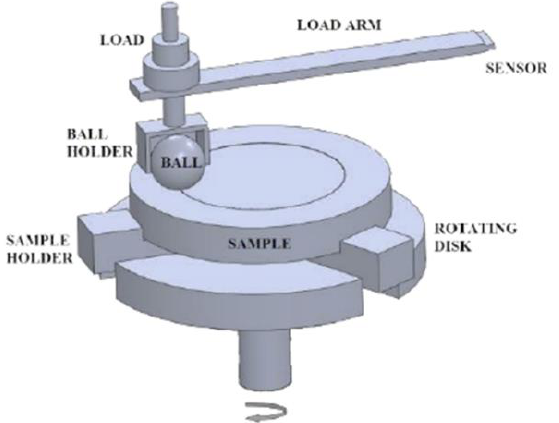
Figure 5. The experimental test stand for testing of samples the ball-on-disc method.